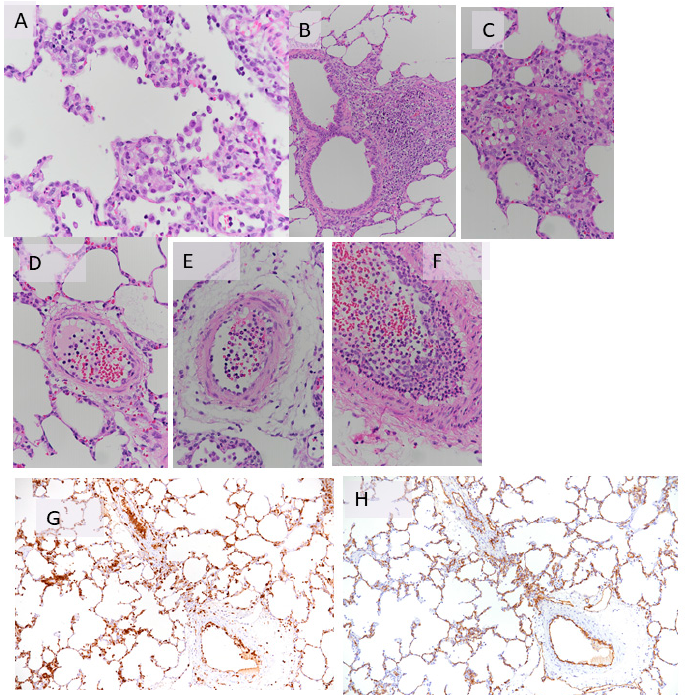
Figure 7. ( A – H ) Histology of the control group at the end of 4 h reperfusion showed that there was moderate to severe multifocal alveolar damage with desquamated alveolar macrophages/type II pneumocytes in the alveolar lumen, also admixed with occasional neutrophils (( A – C ): HE Staining). Occasional apoptotic/karyorrhectic cells are observed, especially interstitial macrophages (( D – F ): HE